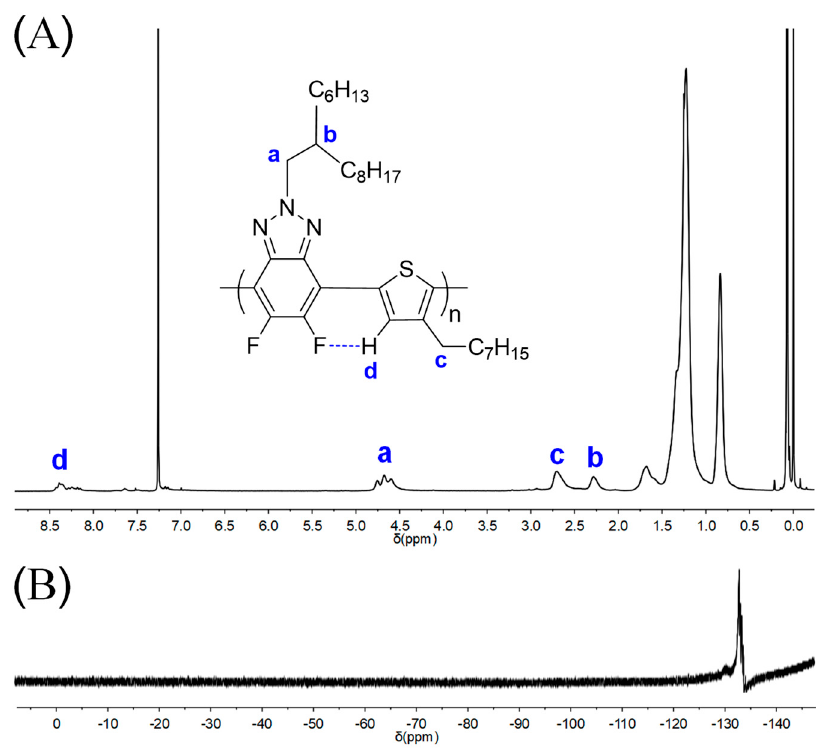
Figure 1. 1 H NMR ( A ) and 19 F NMR ( B ) of P1 in CDCl 3